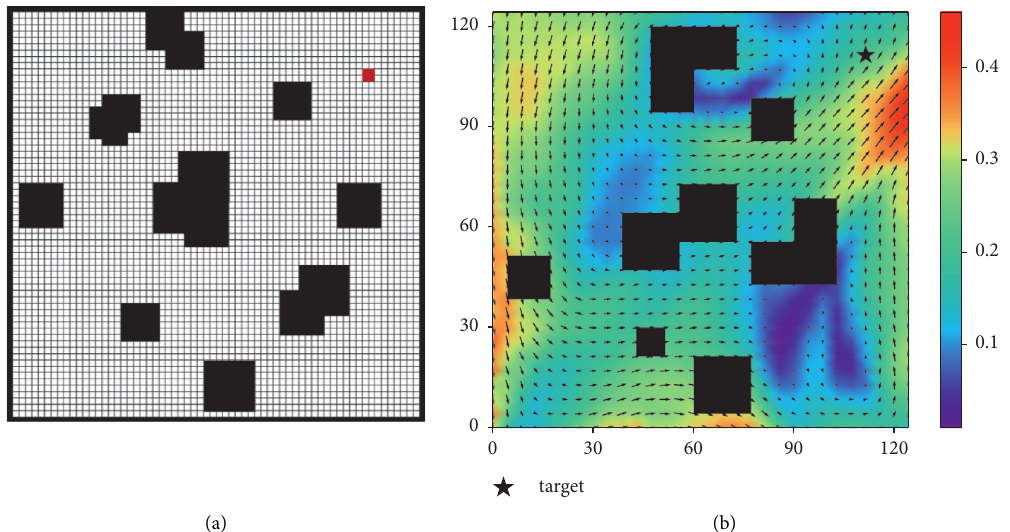
Figure 6: Example data images of two datasets. (a) One grid maps of maps dataset. (b) One Ocean data images of Oceans maps of maps dataset.